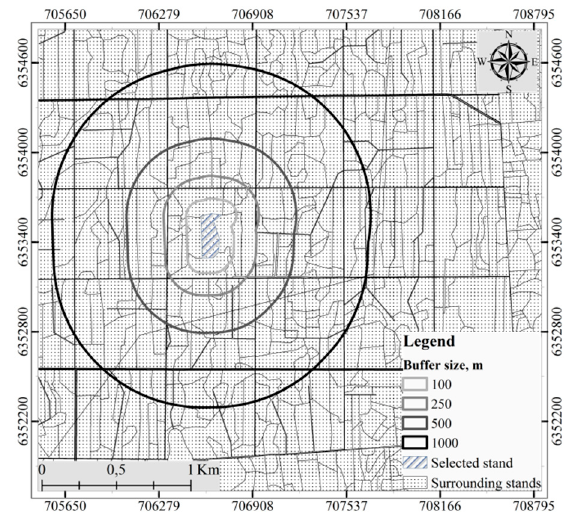
Figure 2. The selected stand surrounded by other stands in the forest massif overlaid with a layer of buffer areas used for calculation of the Shannon diversity index.